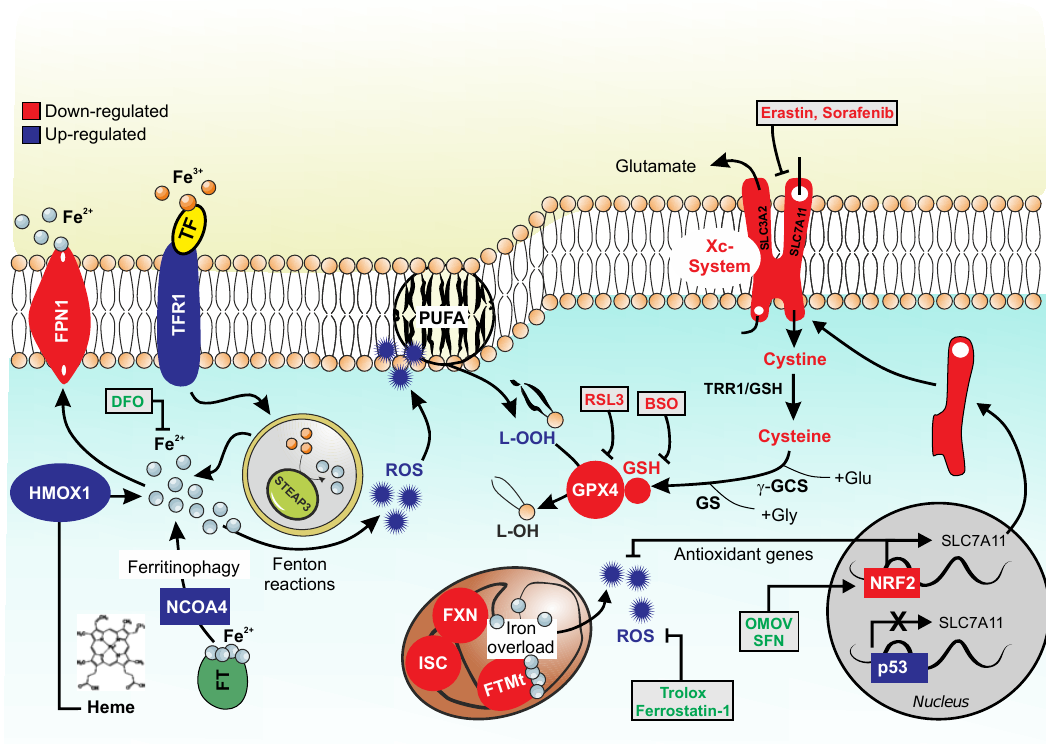
Figure 1. Ferroptotic markers in Friedreich’s ataxia. The figure recapitulates the hallmarks of ferroptosis that are also characteristic of FRDA. Down-regulated factors are represented in red, while up-regulated factors are represented in blue. The figure shows reactive oxygen species (ROS) overproduction due to di ff erent causes. FXN-deficiency leads to accumulation of free iron that is not correctly bound by storage systems, such as FTMt and iron-sulfur clusters (ISC) at the mitochondrial level. Moreover, the free iron pool increases due to: augmented activity of heme oxygenase-1 (HMOX-1), which releases free iron from heme degradation; up-regulation of NCOA4, which is involved in ferritinophagy; augmented levels of transferrin receptor 1 (TFR1), which imports iron into the cell; and to insu ffi cient iron export through ferroportin (FPN1). Free iron participates in Fenton reactions and ROS are overproduced causing oxidative stress. Upon FXN deficiency, a reduction in the Xc (SLC7A11 / SLC3A2)-system-mediated cystine import also occurs, likely due to increase of P53 and decrease of NRF2 activity that represses and induces SLC7A11 transcription, respectively. This leads to the lowering of intracellular cysteine pool, thus decreasing GSH synthesis and glutathione peroxidase 4 (GPX4) activity. An overproduction of harmful lipid peroxides (LOOH) is elicited, that further contribute to ROS overproduction. Finally, the level of Nuclear factor erythroid 2-related factor 2 (NRF2), the main transcription factor involved in the expression of antioxidant genes with a strong anti-ferroptotic potential, results reduced. Ferroptosis inducers: RSL3, GPX4 inhibitor; BSO (L-buthionine sulfoximine), GSH synthesis inhibitor; erastin